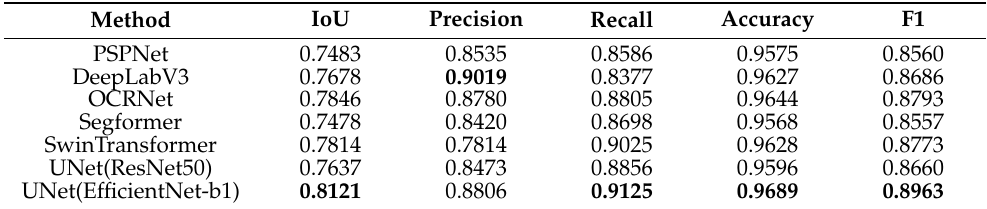
Table 4. Evaluation metrics of the results obtained by different semantic segmentation methods on the Beijing Huairou district land survey dataset.